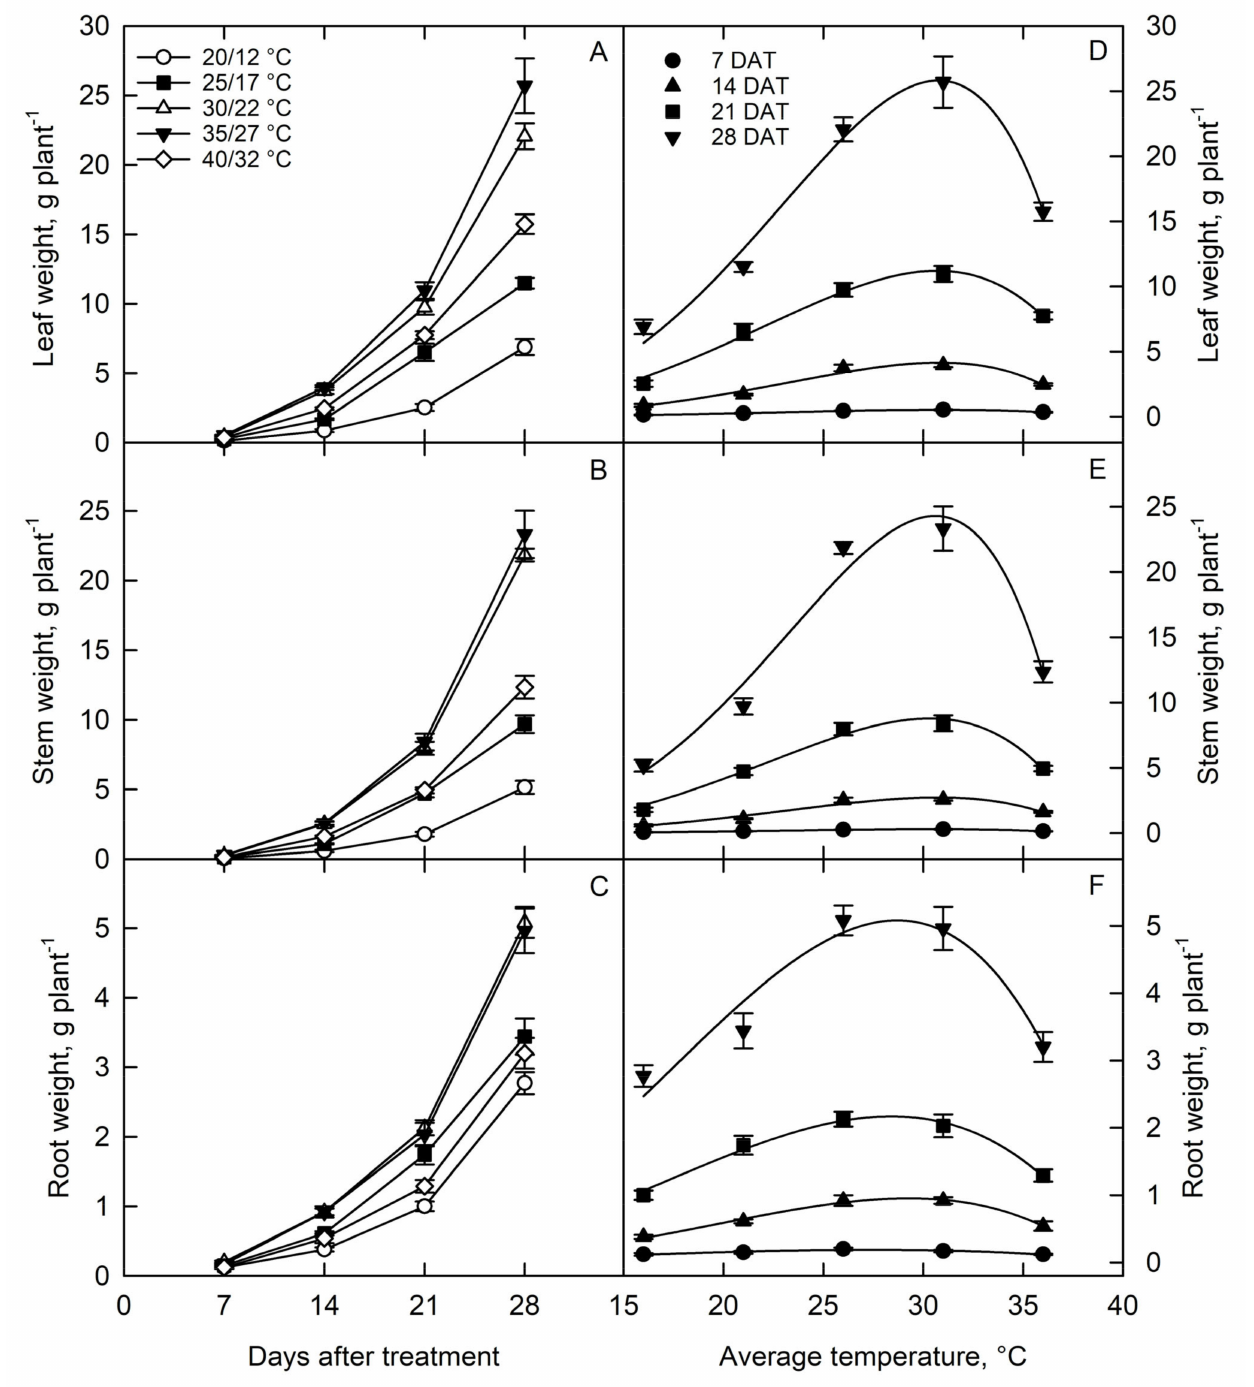
Figure 6. Temporal trends of plant dry weight components, ( A ) leaf dry weight, ( B ) stem dry weight, and ( C ) root dry weight for plants grown at different temperatures as function days after treatment, and mean biomass accumulation rates of various plant components, ( D ) leaf, ( E ) stem, and ( F ) roots as a function of temperature at different time periods. A modified beta function model best described the biomass accumulation rates of various plant components as a function of temperature. All values are the mean ± standard error of six replications at each harvest under each